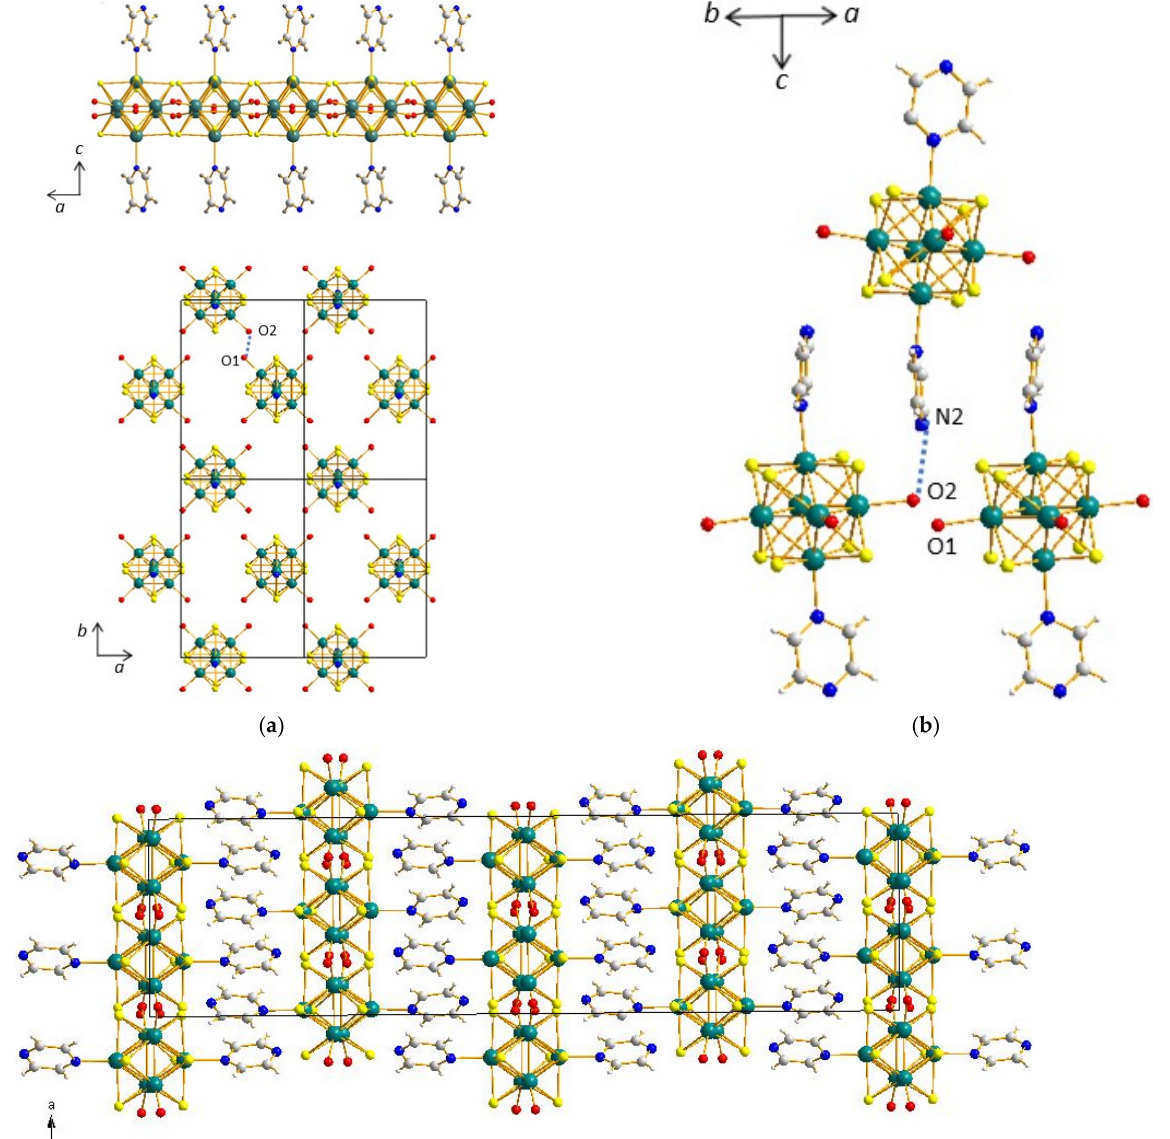
Figure 2. ( a ) Projections along the b and c axes of the structure of ( 1 ) depicting a two-dimensional network based on H 3 O 2 − bridges. ( b ) View of the structure of ( 1 ) showing hydrogen bonds along the c axis. ( c ) Projections along the b axis of the supramolecular structure of ( 1 ).